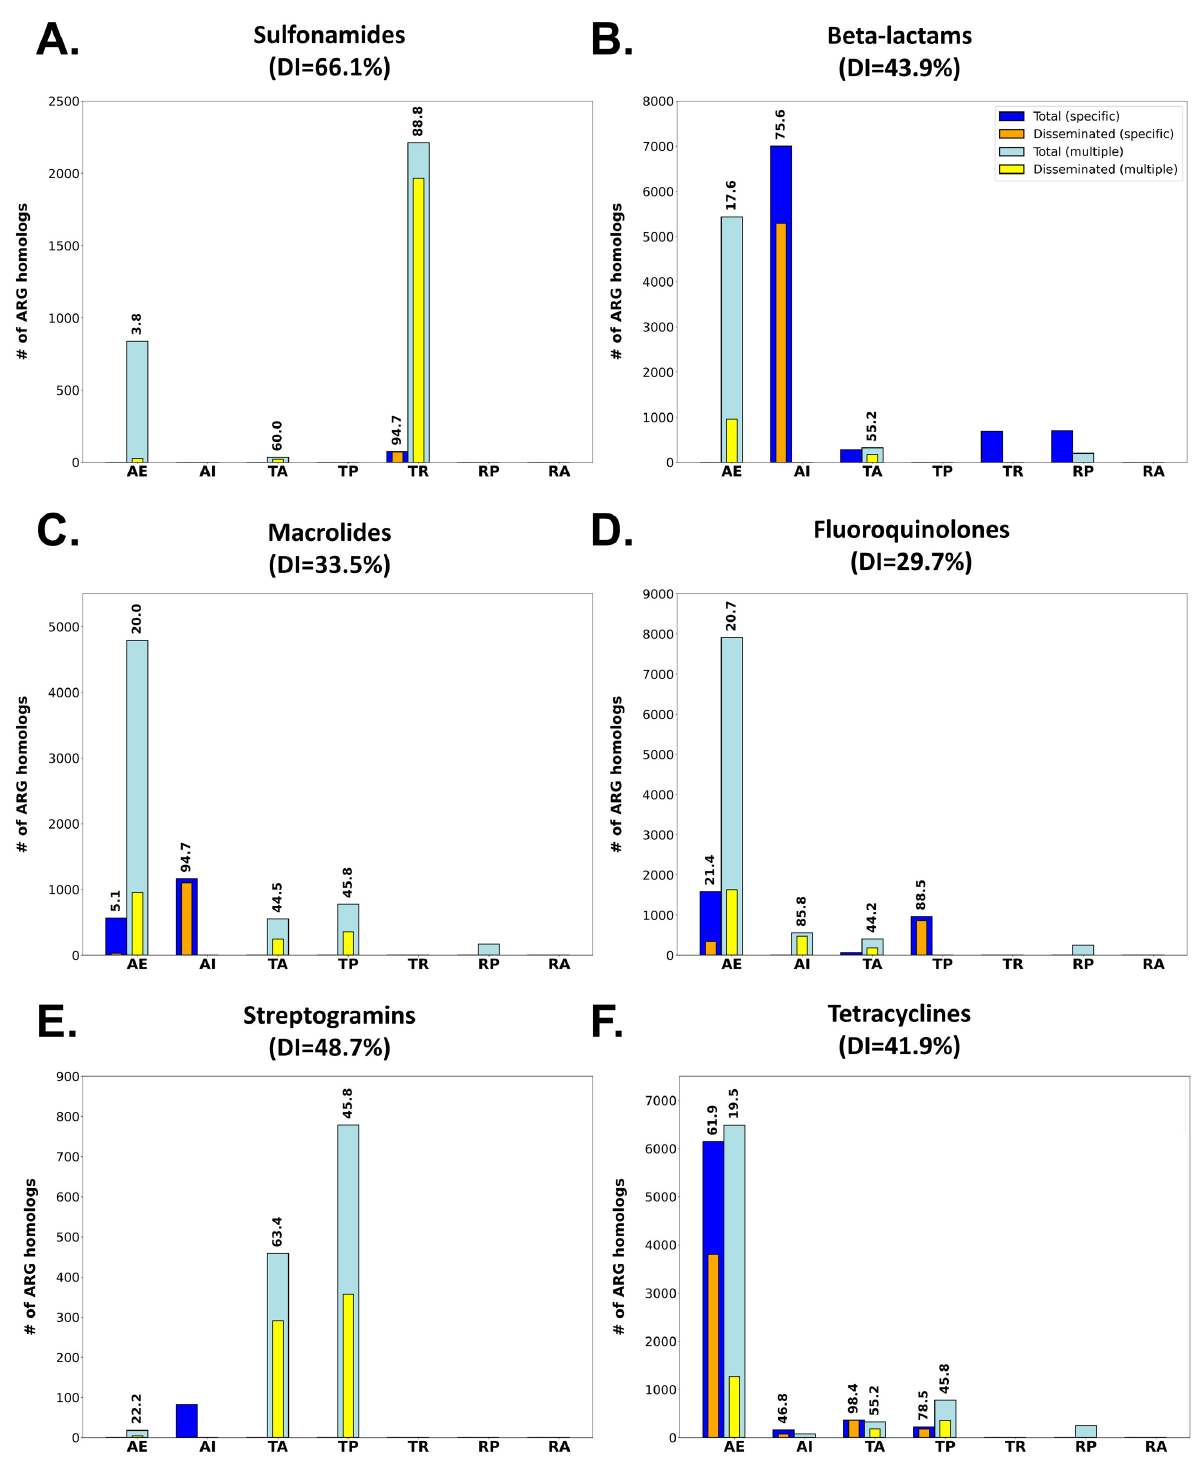
Figure 6. Bar plots showing the total vs. disseminated number of ARG homologs matching single (Specific) or several (Multiple) CARD Drug Classes and conferring resistance to sulfonamides ( A ), beta-lactams ( B ), macrolides ( C ) fluoroquinolones ( D ), streptogramins ( E ) or tetracyclines ( F ). ARG homologs are also split according to their CARD Resistance Mechanism: target alteration (TA), antibiotic efflux (AE), antibiotic inactivation (AI), resistance by absence (RA), target replacement (TR), reduced permeability (RP) or target protection (TP). Dissemination index values for each group are superimposed if larger than